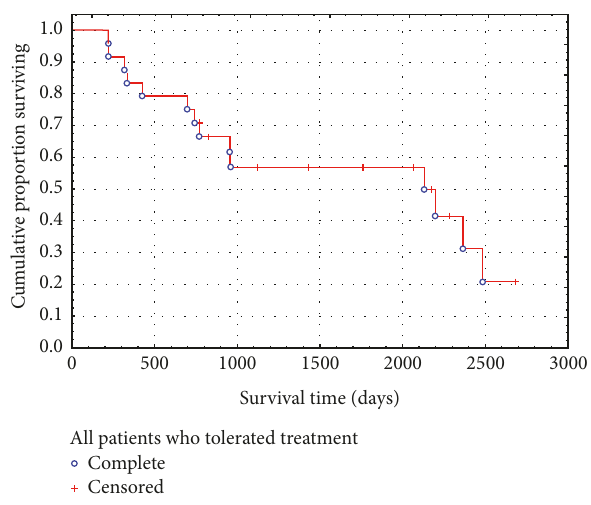
Figure 3: Survival rate of the study population receiving PAHST up to 6